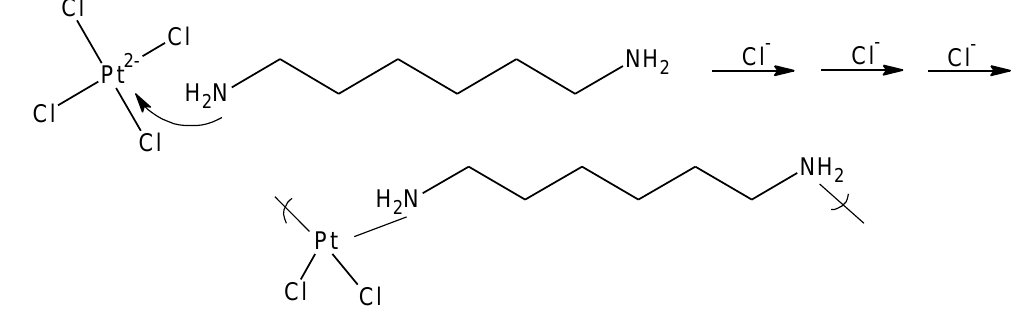
Figure 15. General reaction scheme for the reaction between tetrachloroplatinate and 1,6-hexanediamine forming the platinum-containing